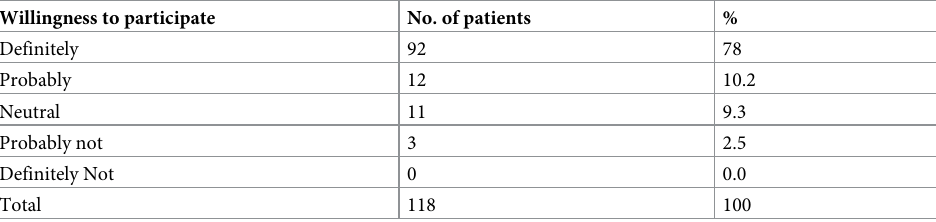
Table 2. Willingness to participate in clinical research of children with